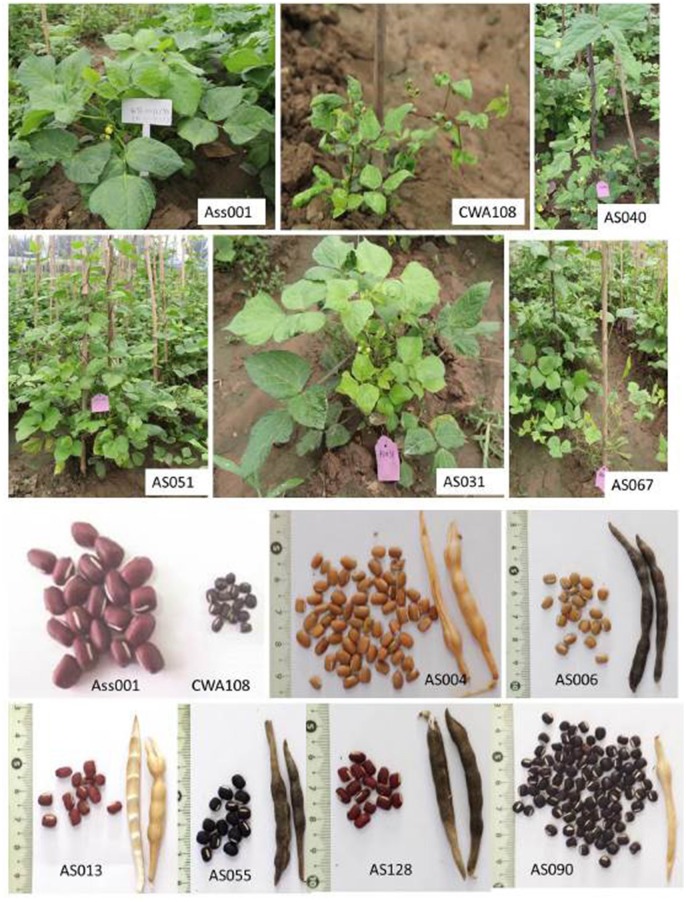
Phenotype of parents (Ass001 and CWA108) and several individuals in the F2 mapping population Ass001: female parent; CWA108: male parent; AS: individuals of F2.